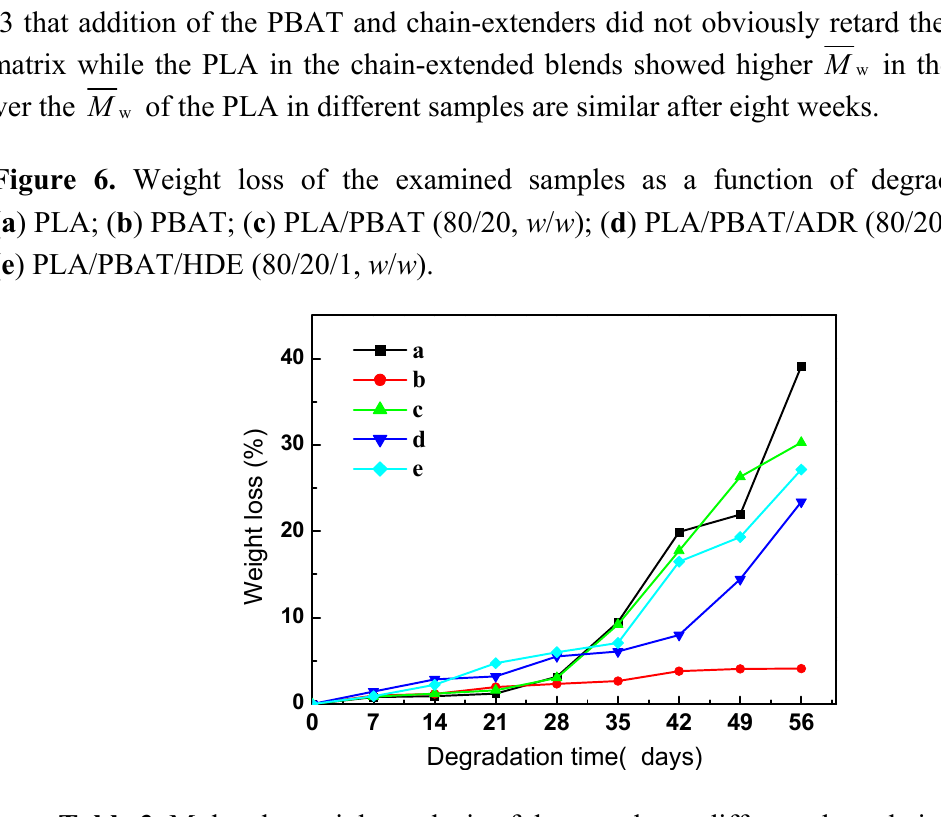
Table 3. Molecular weight analysis of the samples at different degradation